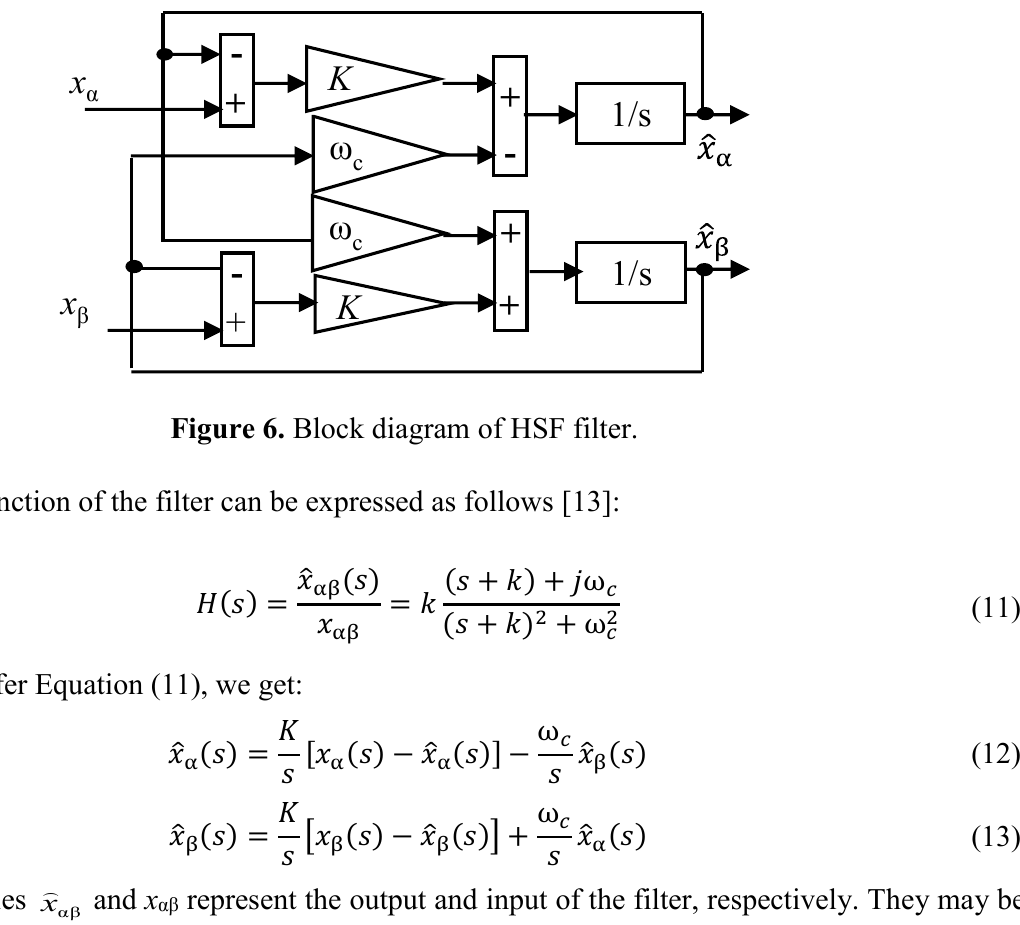
Figure 5. Computation of vα, vβ, 𝑝̃ & qs with HSF.